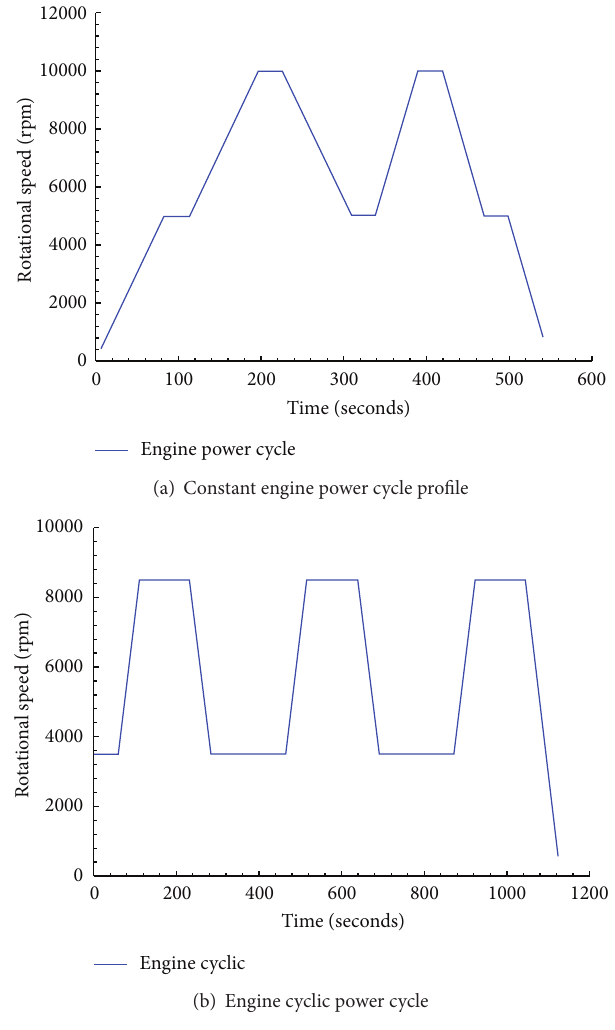
Figure 4: Simulated engine mission history test